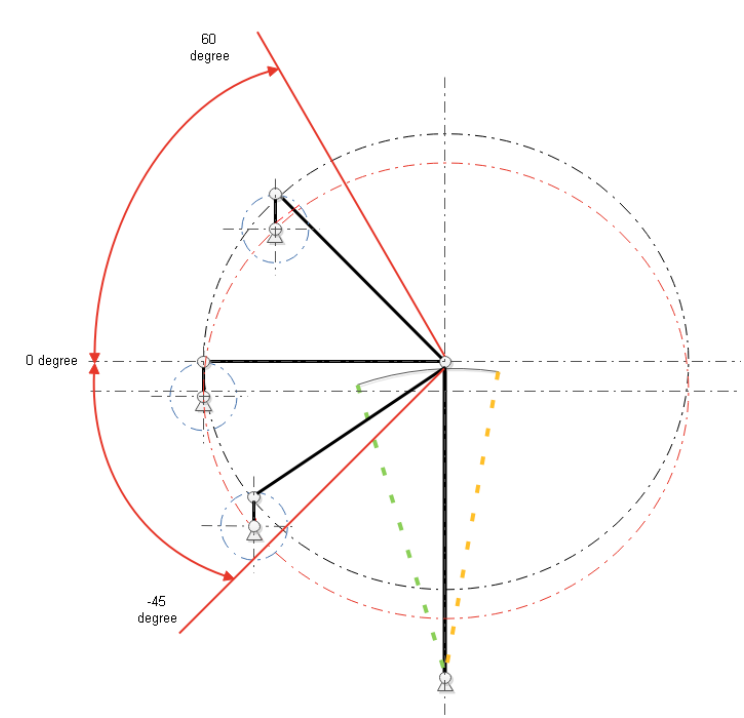
Figure 3. Variation of the position of the drive mechanism.